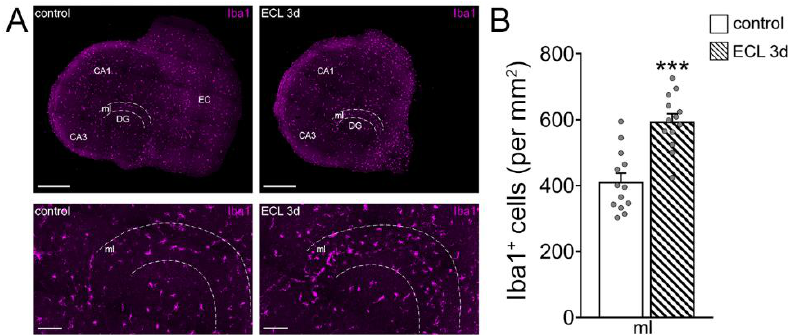
Figure 4. Recruitment of microglia in the denervated region. ( A ) Representative images of non- denervated controls and age- and time-matched denervated tissue cultures 3 days after entorhinal cortex lesion (ECL), stained for the microglial marker Iba1. The molecular layer (ml) is shown at higher magnification. Scale bars (top) 400 µm (bottom) 100 µm (DG, dentate gyrus; CA1, Cornu Ammonis Area 1; CA3, Cornu Ammonis Area 3). ( B ) Group data of the number of Iba1 + cells in the ml of DG in intact and denervated tissue cultures (control, n = 13 cultures; ECL 3d, n = 13 cultures; Mann – Whitney test; *** p < 0.001).